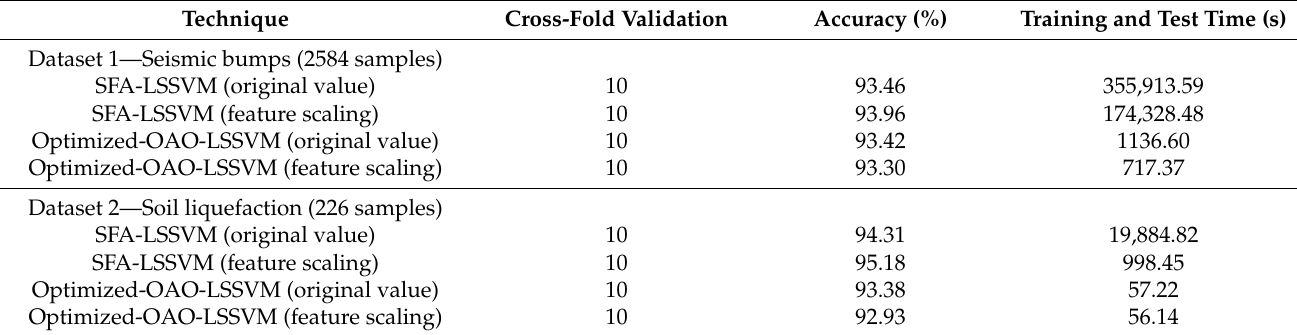
Table 5. Comparison of performances of SFA-LSSVM and Optimized-OAO-LSSVM models used to solve binary